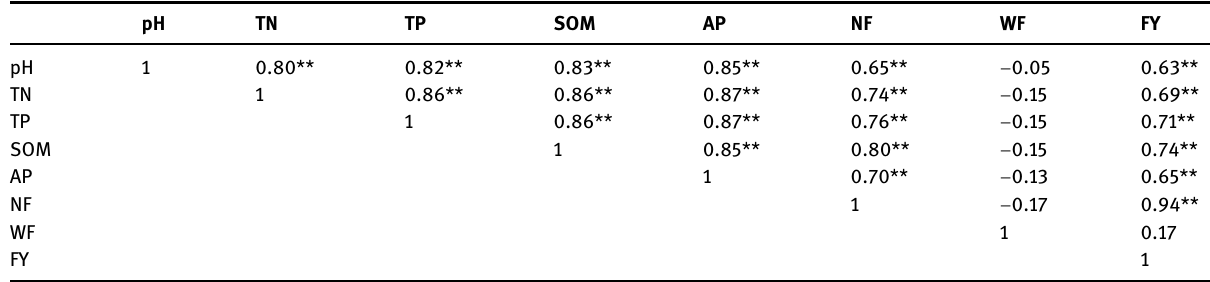
Table 5: Pearson correlation matrix between the soil quality properties of topsoil layer and fruit yield ( n = 48 ) pH TN TP SOM AP NF